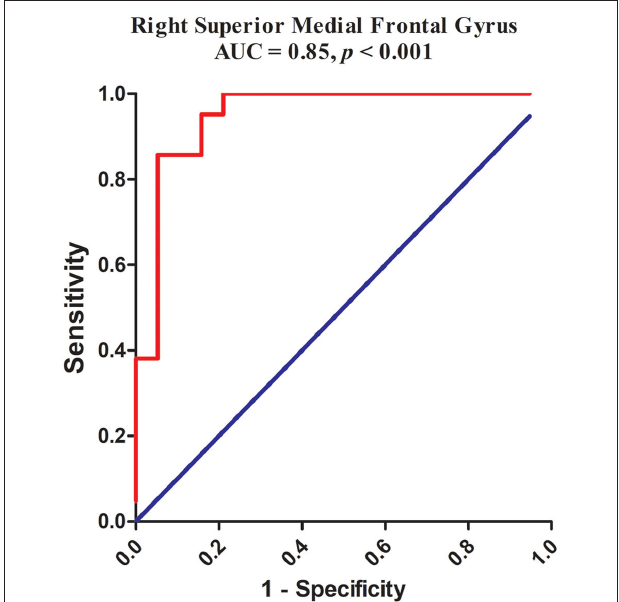
FIGURE 4 | Receiver operating characteristic (ROC) curves using the mean NH in the right superior medial frontal gyrus to separate the patients from healthy controls. NH, network homogeneity.